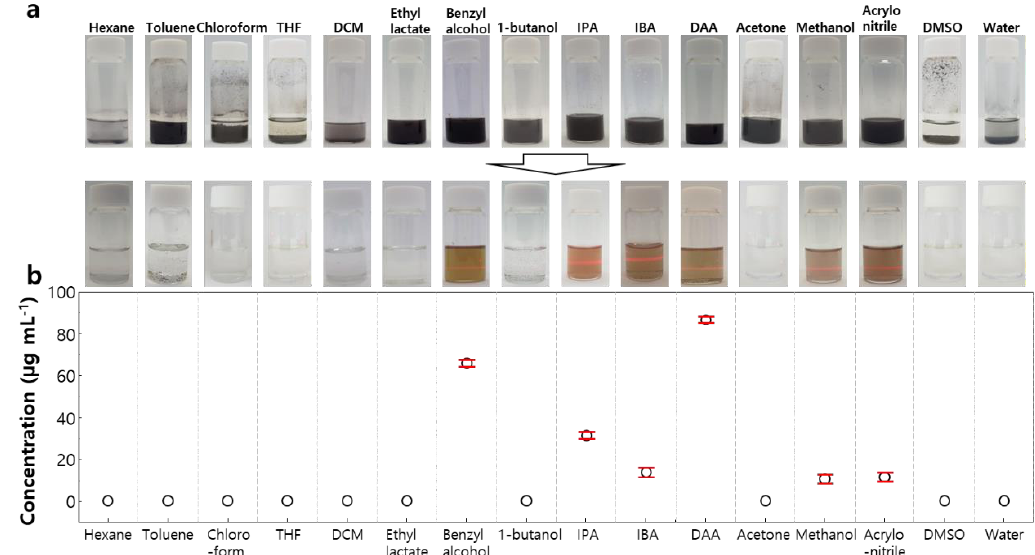
Figure 2. ( a ) Photographs of dispersion solutions after ultrasonication (top) and separated supernatant after centrifugation exhibiting a Tyndall effect (bottom); ( b ) Concentration of the Nb 2 Se 9 dispersion solution depending on the solvent. Error bars represent standard deviations obtained from three measurements of the same sample.